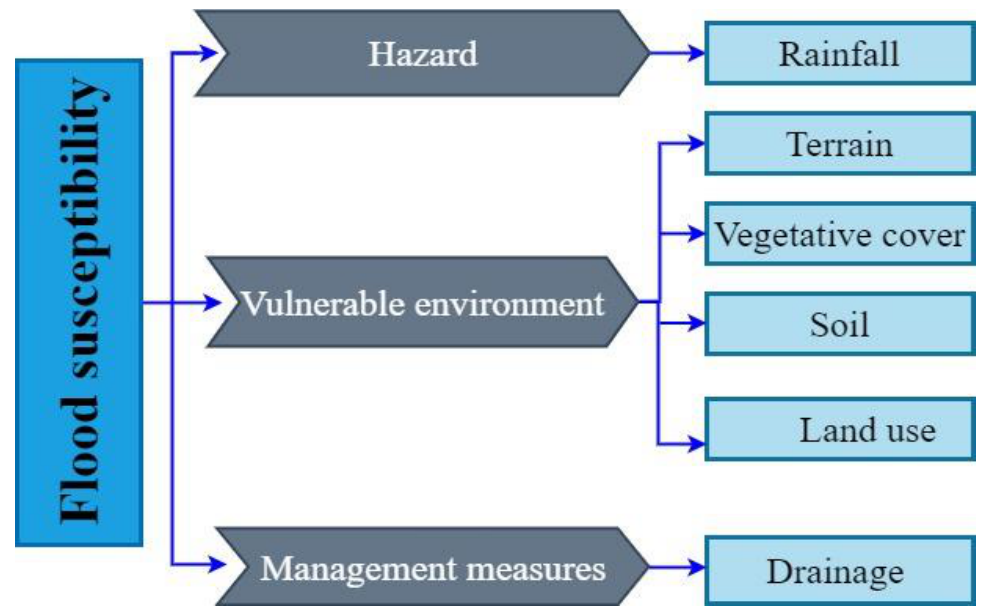
Figure 3. The conceptual framework of flood susceptibility.